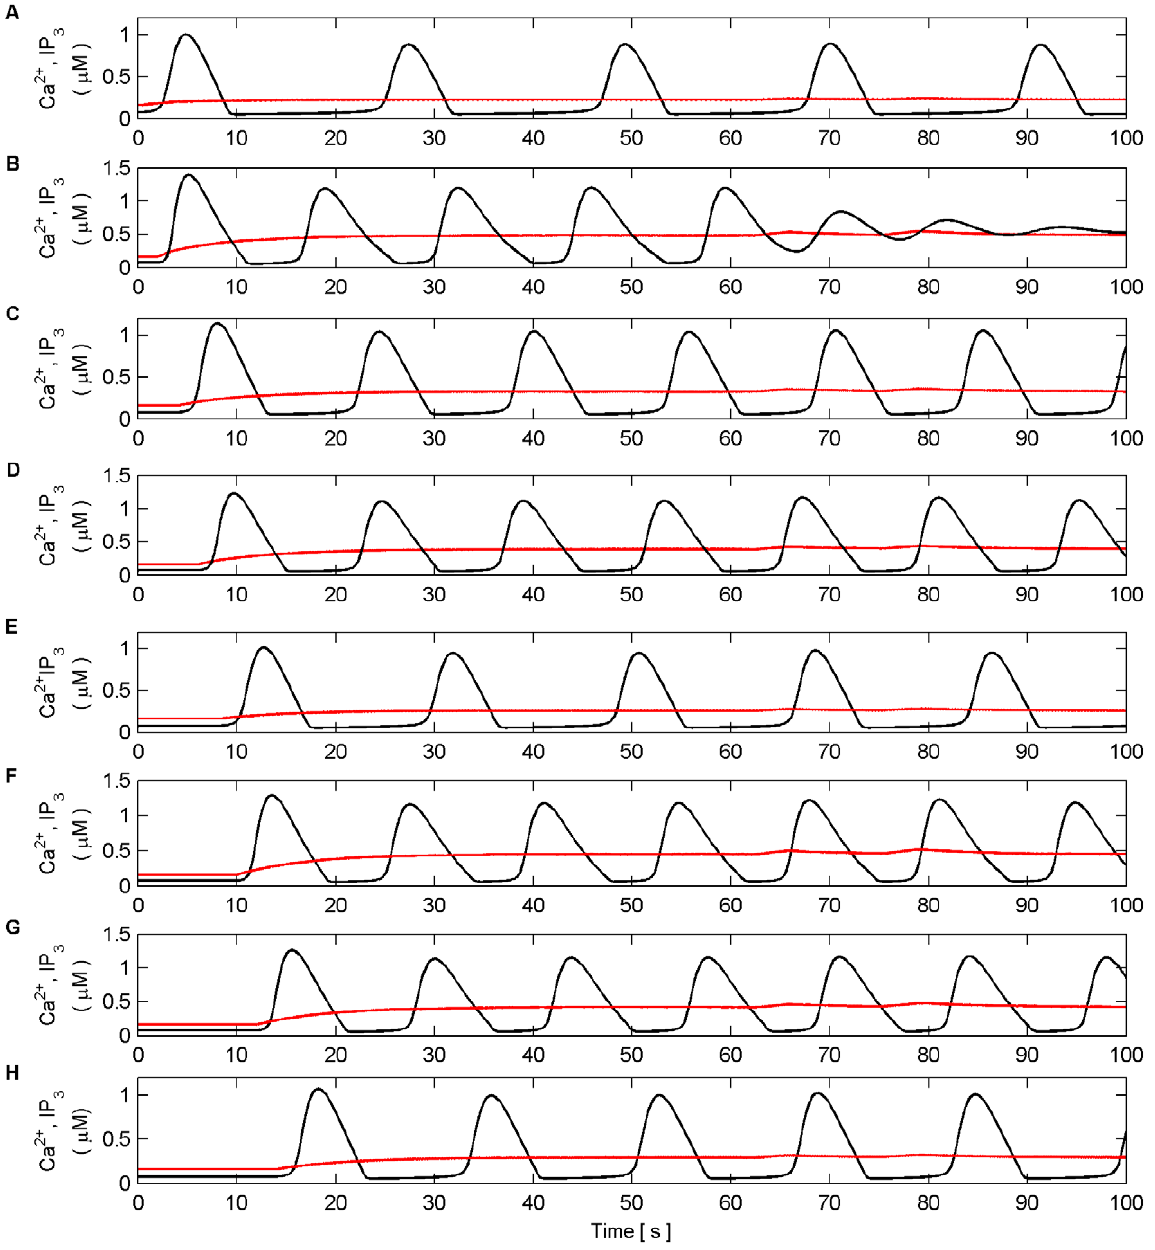
Figure 21. Individual Ca 2 + oscillations and IP 3 levels in the AM-FM mode. (A–H) Individual Ca 2 + oscillations (black), IP 3 transients (red) in each of the 8 microdomains associated with the synapses of N1 (A–D) and N2 (E–H). The input stimulus to each microdomain is a Poisson spike train with an average frequency of (A) 2 Hz, (B) 10 Hz, (C) 5 Hz, (D) 7 Hz, (E) 3 Hz, (F) 9 Hz, (G) 8 HZ, (H) 4 Hz. Note there is no phase locking of the individual microdomain